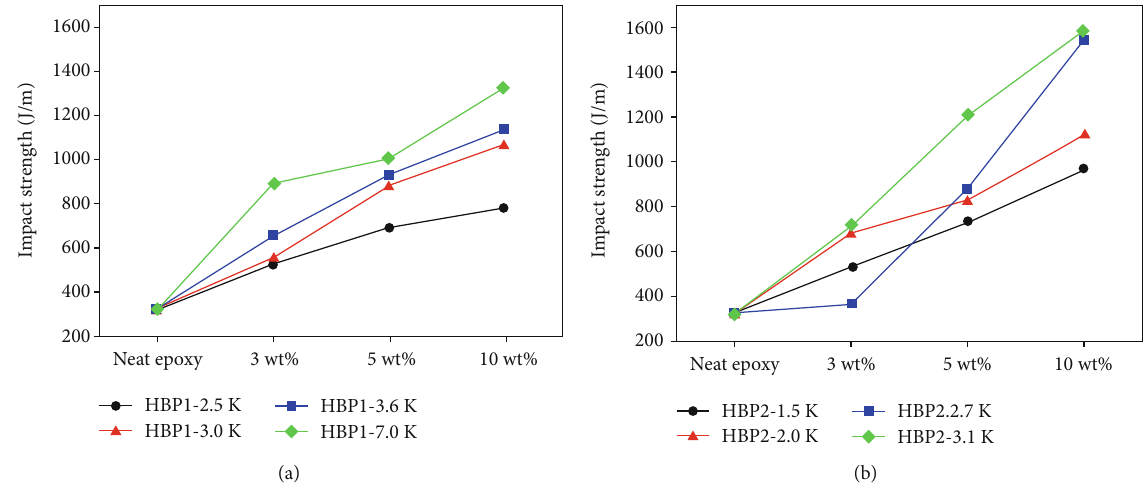
Figure 7: Impact strength of (a) epoxy/HBP1 and (b) epoxy/HBP2 blends with di ff erent molecular weights and HBP